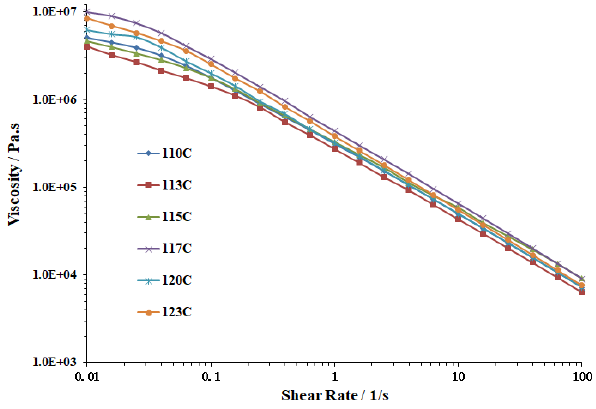
Figure 1: Measured viscosities as a function of shear rate at differ- ent test